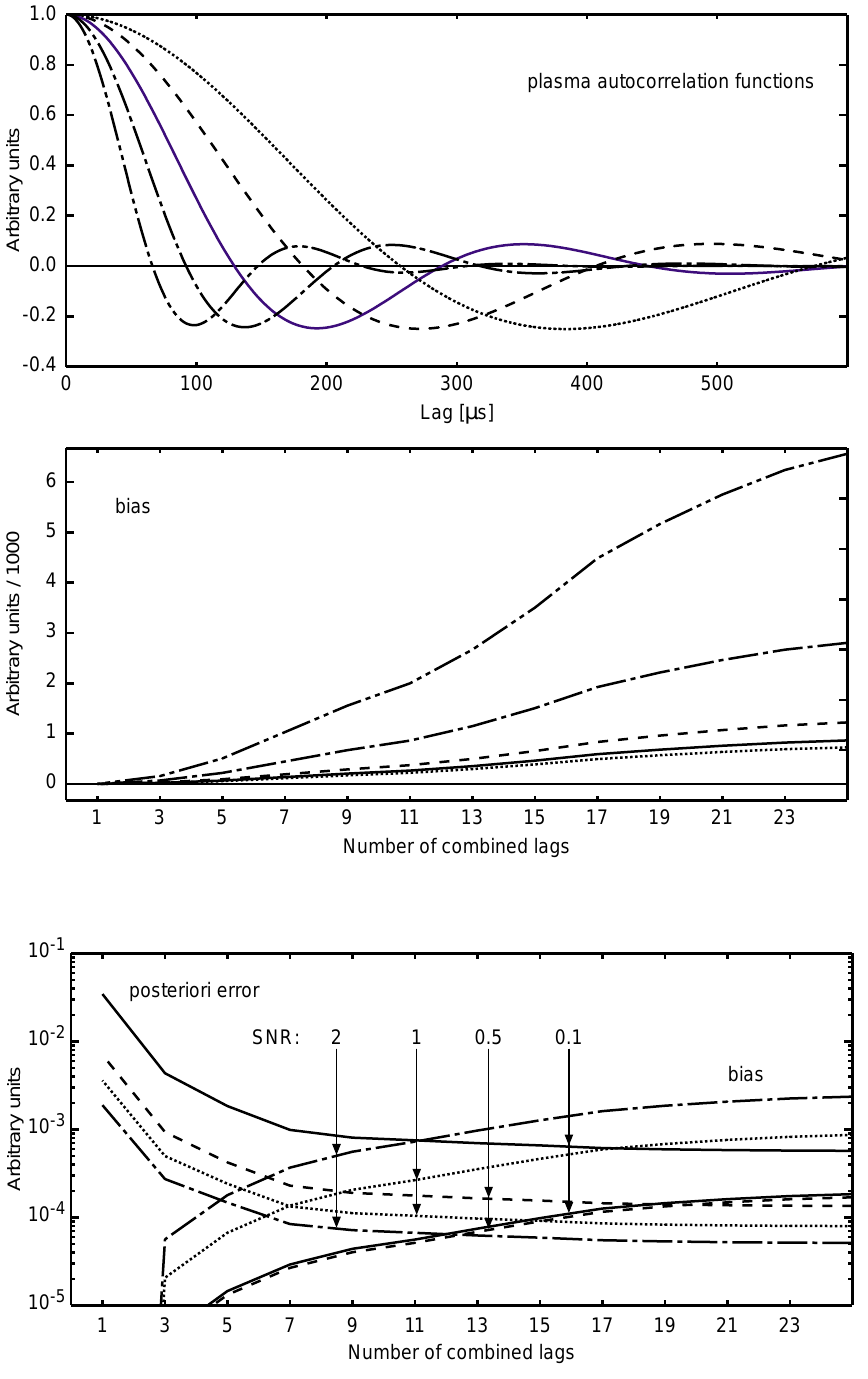
Fig. 2. The a posteriori standard devi- ation and the absolute value of the bias for different values of SNR as functions of the number of lags merged into the 90- µ s nominal lag in the analysis. The calculations are made for the plasma ACF shown by the continuous line in the top panel of Fig. 1. (The bias for SNR = 0 . 1 is negative; absolute values are plotted in order to allow for the use of logarithmic